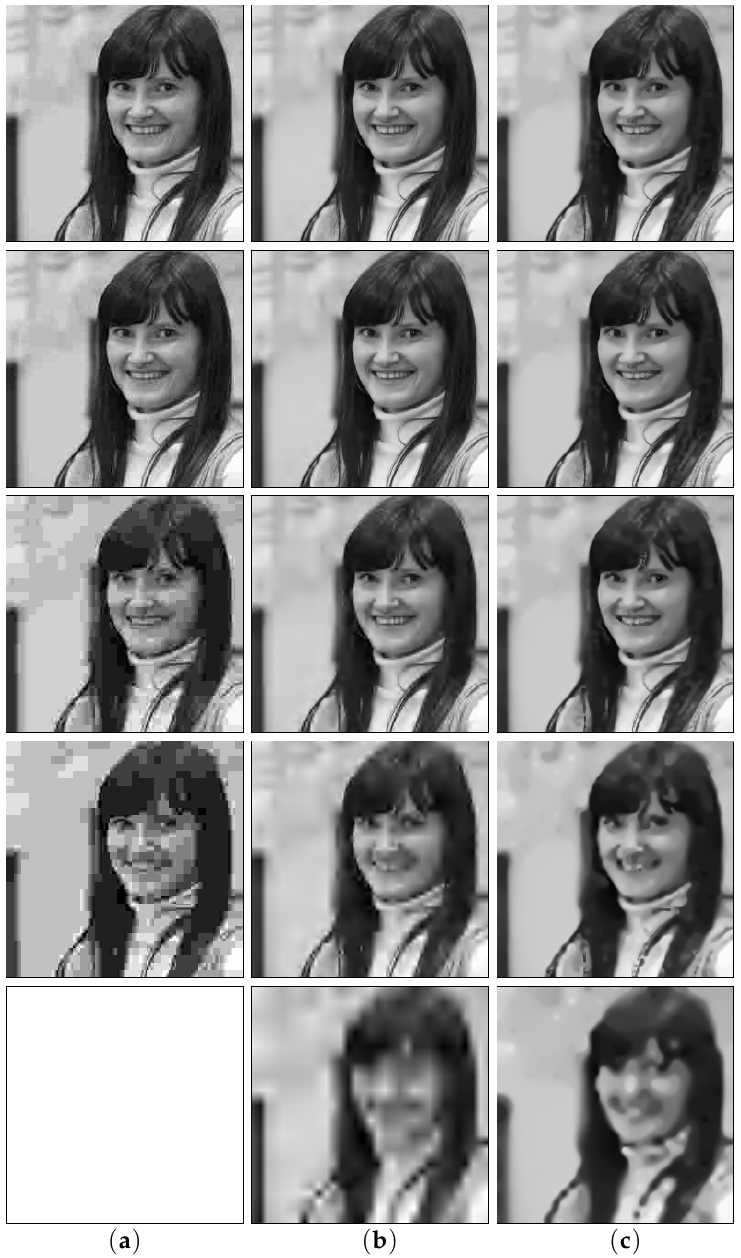
Figure 15. Comparative overview of reconstructed images for image beauty ranging from 0.8 bpp ( top row ) to 0.05 bpp ( bottom row ). Compression methods: ( a ) JPEG, ( b ) JPEG 2000, and ( c )